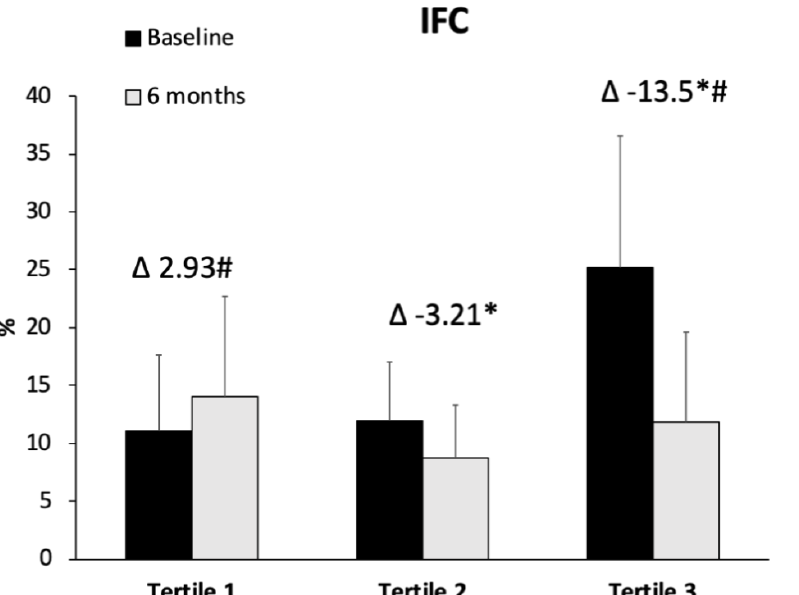
Figure 1. Values are the mean ± SD. Abbreviations: IFC, intrahepatic fat contents. Differences in means of IFC classified in tertiles was tested with one-factor ANOVA and Bonferroni’s post hoc analysis when variables followed a normal distribution or with Kruskal–Wallis test for non-normally distributed variables. * Differences with respect to tertile 1. # Differences with respect to tertile 2.